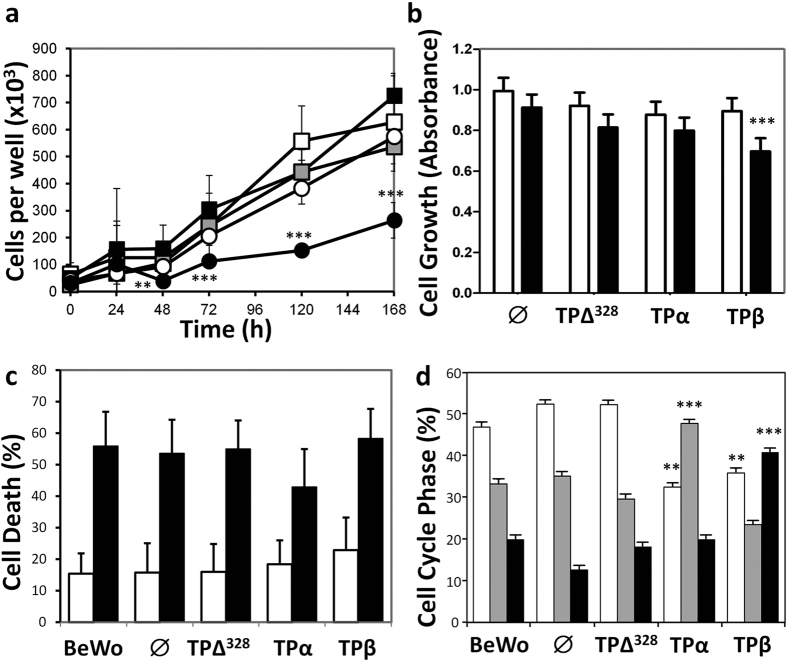
Differential effects of TP isoforms on trophoblast cell cycle.(a) Proliferation of BeWo cells (□) transfected with empty vector-∅ (), TPΔ328 (O), TPα (■) and TPβ (●) was monitored over 168 hours. (b) Proliferation of JEG-3 cells expressing similar constructs, stimulated with vehicle (□) or 100 nM I-BOP (■) was documented over the same period. (c) Apoptosis of BeWo cells under basal (□) and serum-deprivation (■) was assessed after 24 hours using flow cytometry. (d) Distribution of transfected BeWo lines in phases of the cell cycle (G0/G1 □, S , G2/M ■) was assessed also using flow cytometry. The data are represented as mean ± SEM and are representative of 3 independent experiments. One-way ANOVA and Independent samples T-test, *P < 0.05, **P < 0.01, ***P < 0.005.